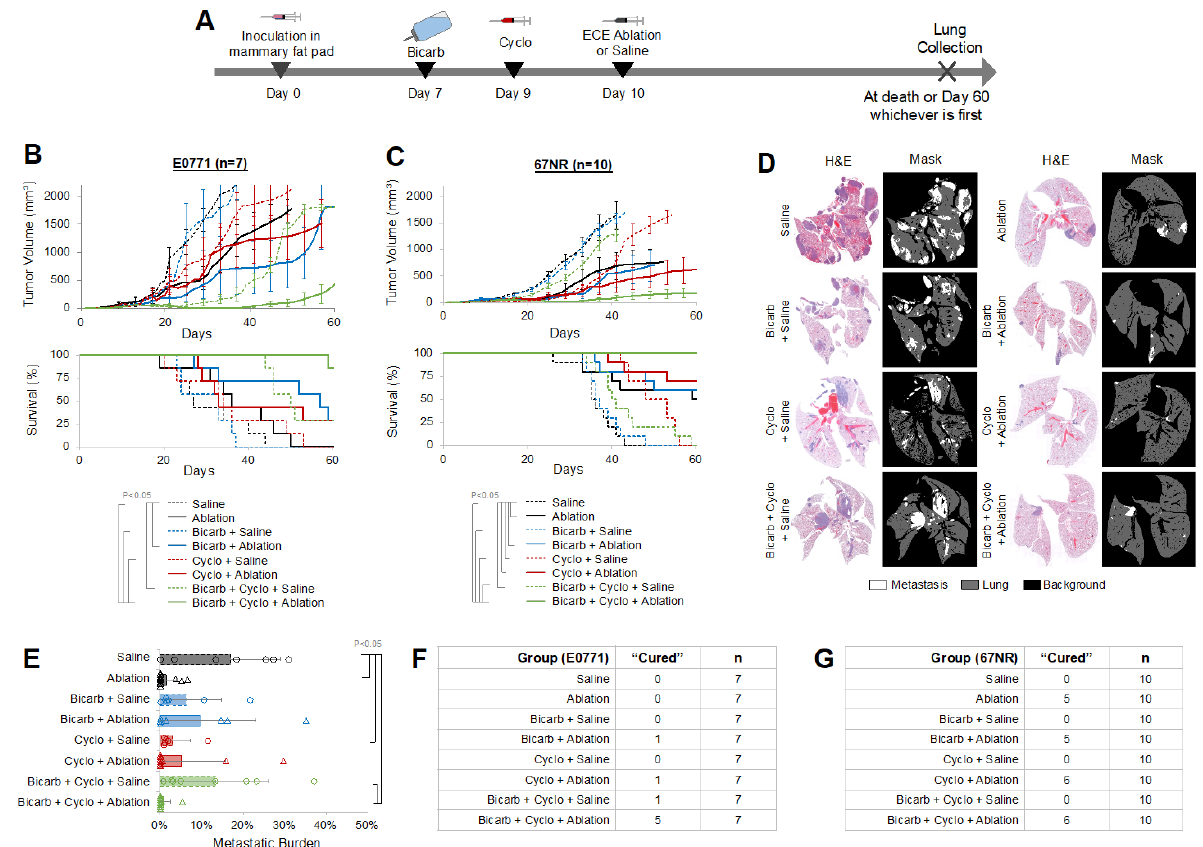
Figure 1. BiCyclA therapy was effective across different cell lines and mouse backgrounds. ( A ) Study timeline schematic for treatment of orthotopic 4T1-luc tumors. ( B ) Primary tumor volume and Kaplan–Meier survival curves for mice bearing E0771 tumors following treatment with BiCyclA (bicarb + cyclo + ablation) or controls. ( C ) Tumor growth and Kaplan–Meier survival curves for mice with 67NR tumors. ( D ) Representative images of whole-lung H&E and quantification mask for each treatment group in mice with 67NR tumors. ( E ) Metastatic burden quantified from the metastatic mask for each group. ( F ) Number of E0771 mice with no detectable tumor at the end of the study ( n = 7). ( G ) Number of mice bearing 67NR tumors out of n = 10 that were without primary tumor or detectable metastases by the end of the study. Brackets indicate p < 0.05.